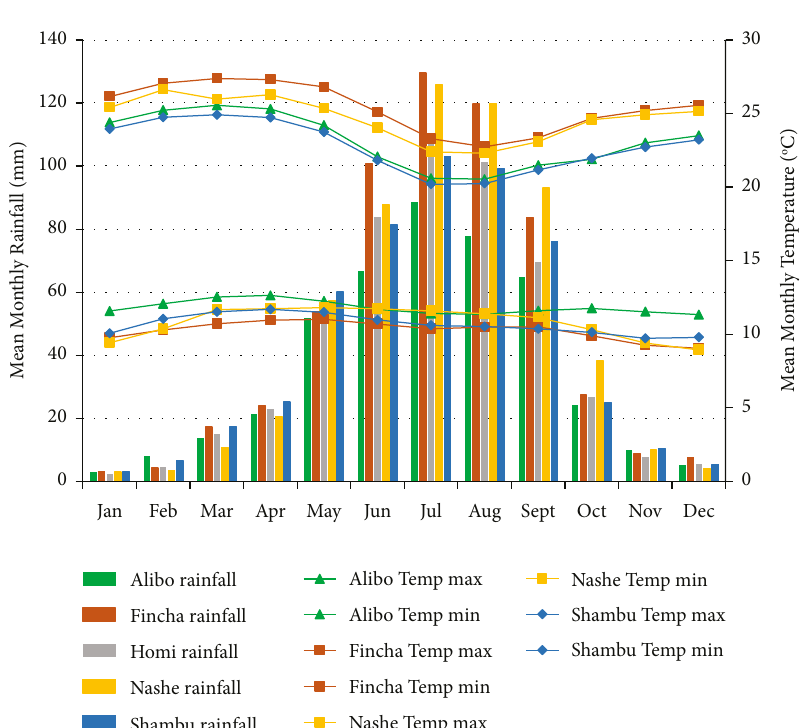
Figure 2: Monthly average rainfall and temperature features of the stations in the Nashe